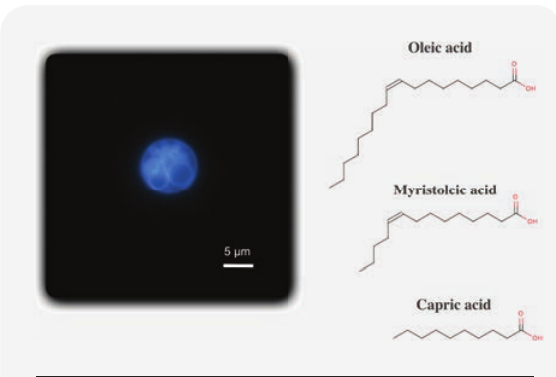
Figure 7. Model protocell membranes. Fatty acids such as oleic, myristoleic and capric acids (right) spontaneously assemble into bilayer membranes which form closed vesicles (left). Such vesicles are used to study the growth, division, permeability and other proper- ties of model protocell